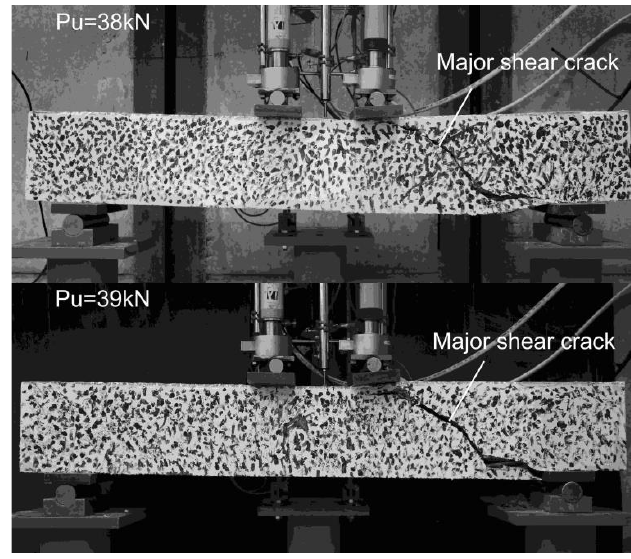
Figure 10. Shear failure of the two validation beams. Table 6. Comparisons of predictions of shear design provisions and proposed data-driven models. Design Provision